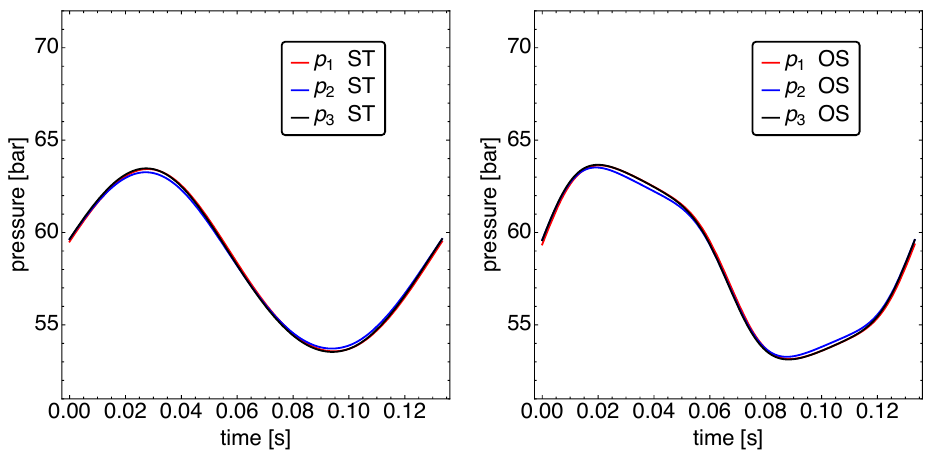
Figure 10. The temperature differences between the internal reservoirs T corresponding external reservoirs T H , T C , and T M vs. time during one cycle at 450rpm for ST motion ( left ) and OS motion ( right ). The figure gives direct insight into the the heat flows, which are proportional to the respective temperature differences. The figure reveals that there are two periods during the cycle in which all heat flows are small, separating a phase in which the hot and cold reservoirs receive heat; the medium reservoir discharges heat from a phase in which the cold heat flux remains small while the hot reservoir gains and the medium reservoir looses heat.